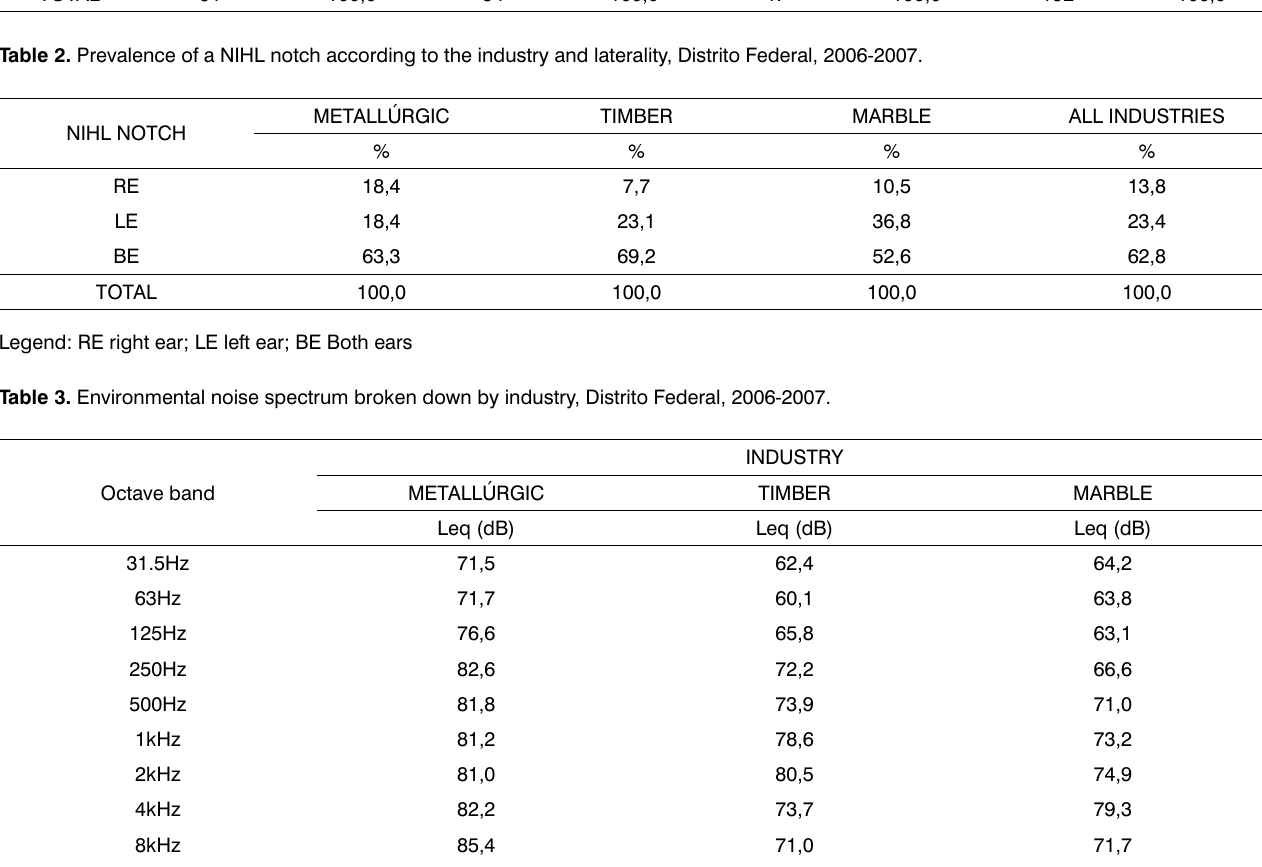
Table 2. Prevalence of a NIHL notch according to the industry and laterality, Distrito Federal, 2006-2007.